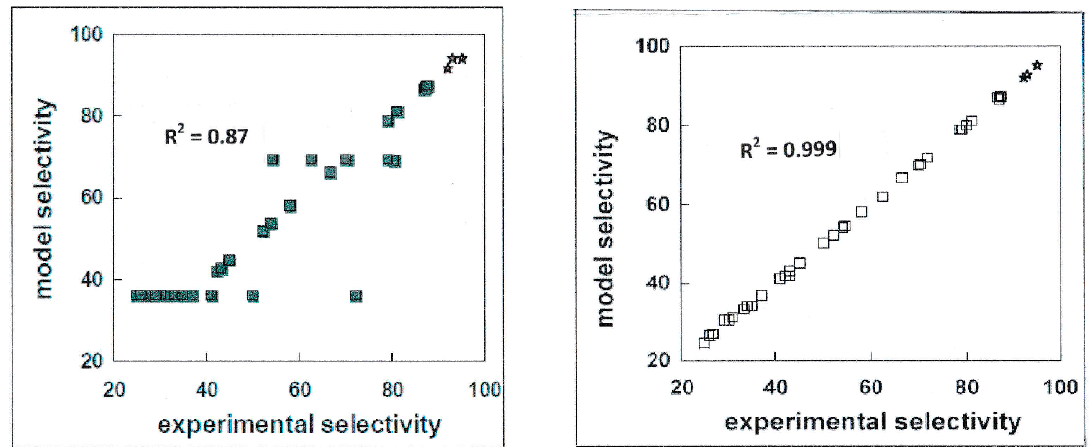
Figure 4. Experimental versus model selectivity for a realistic catalyst system. These plots serve to illustrate that in this case, where the main interest is to have a high selectivity, it does not matter that much if the method is not that good: in both cases, the same 3 data points represent the best catalysts (right hand top corner, star symbols).